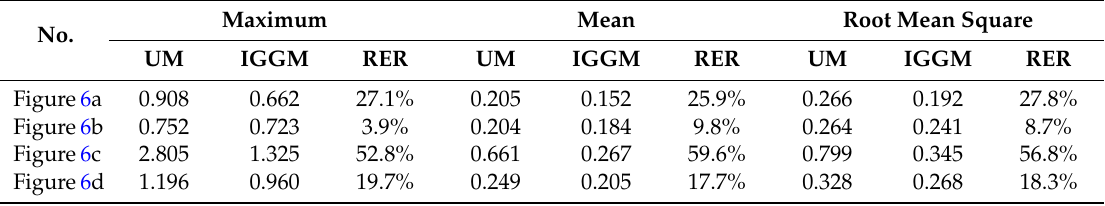
Table 1. Center extraction error by the Usamentiaga’s method (UM) and IGGM